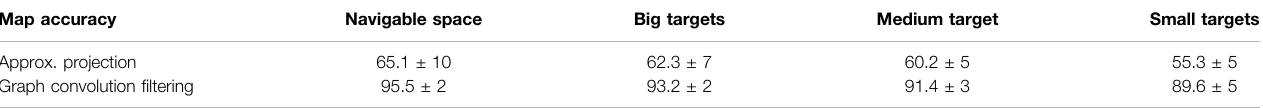
TABLE 4 | Table showing comparison of performance improvement in predicting the class of each node in grid projection map when using Graph convolution fi ltering over approximate projection map as compared to only approximate projection map. Map accuracy Navigable space Big targets Approx.